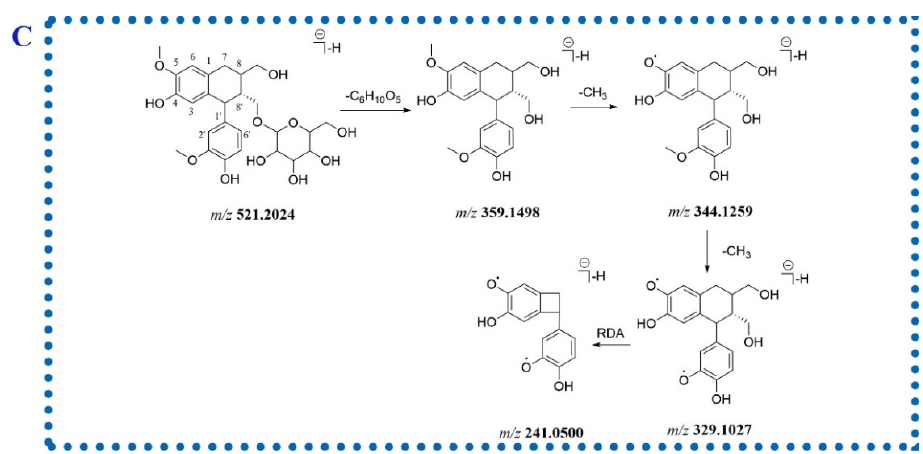
Figure 3. The fragmentation patterns of compounds 84 ( A ), 110 ( B ) and 77 ( C ).